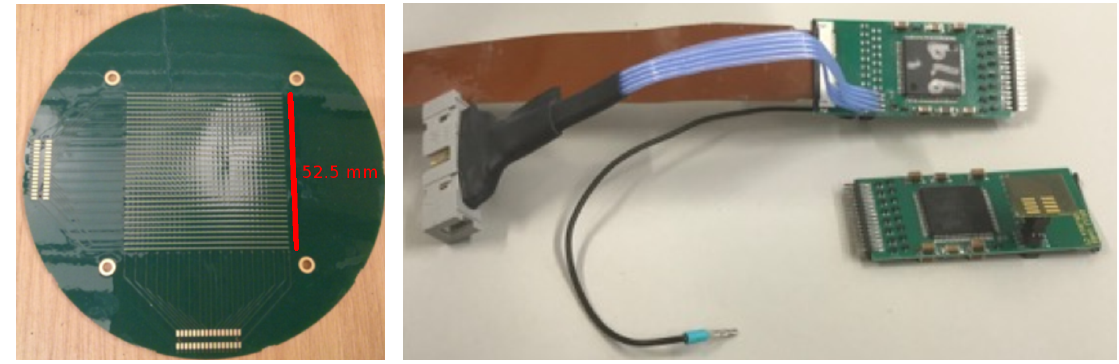
Figure 4. Charge-readout system consisting of 64 conducting strips printed on two planes, separated by 50µm of Kapton and four LARASICs mounted on two PCBs for the charge